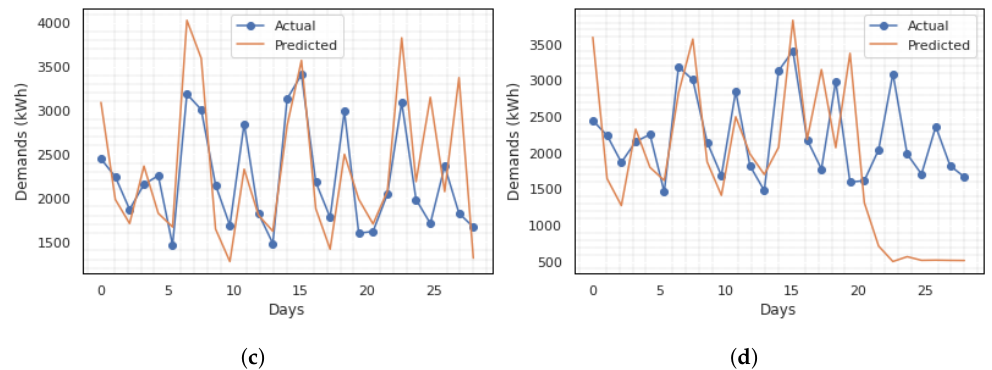
Figure 2. The 28 days actual vs. predicted value for different input sizes. ( a ) 7 days input; ( b ) 14 days input; ( c ) 21 days input; ( d ) 28 days input.